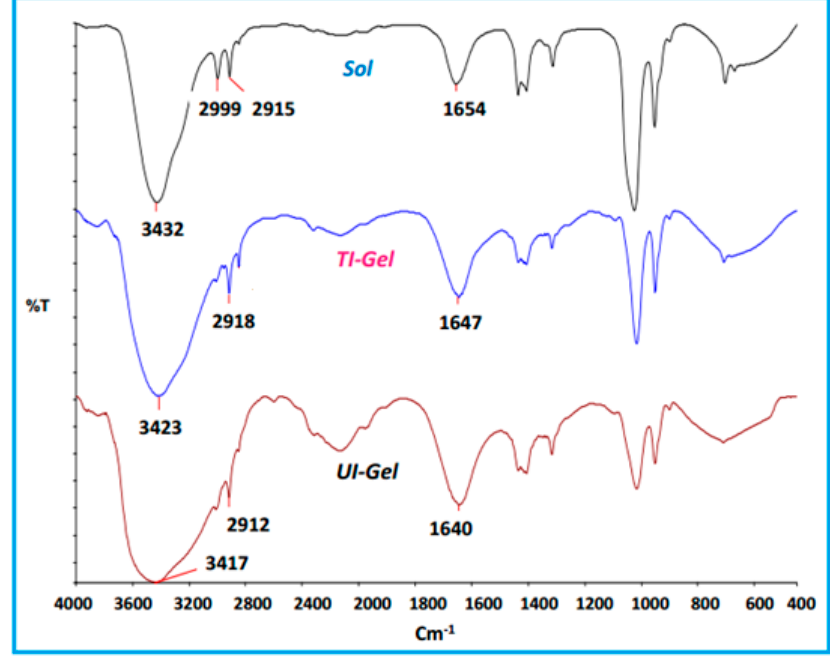
Figure 2. FTIR spectrum of sol, thermally-induced (TI) gel and ultrasound-induced (UI) gel of the gelator in dimethyl sulfoxide (DMSO)/water mixtures (80/20 v / v ) at a concentration of 30